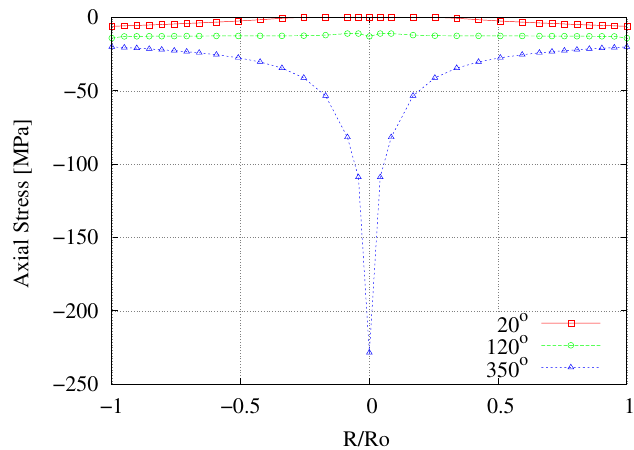
Figure 17. Numerical radial profiles for the longitudinal stress σ zz in plane 1 for different torsion angles.